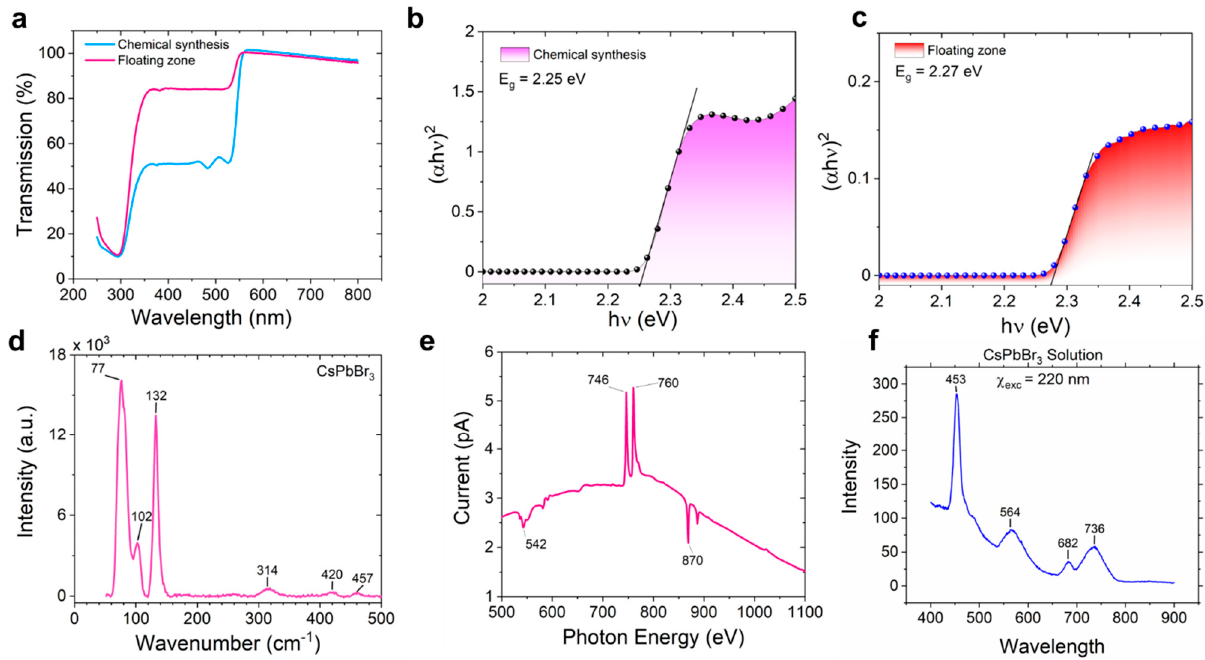
Figure 5. ( a ) The transmittance spectra of CsPbBr 3 crystal, synthesized using the chemical (blue curve) and floating zone (pink curve) method. The bandgap of the ( b ) chemically synthesized and ( c ) floating zone synthesized CsPbBr 3 was calculated using the Tauc plot. ( d ) Raman spectra show the phonon modes of CsPbBr 3 . ( e ) CsPbBr 3 crystal was exposed to soft X-ray light using a plane